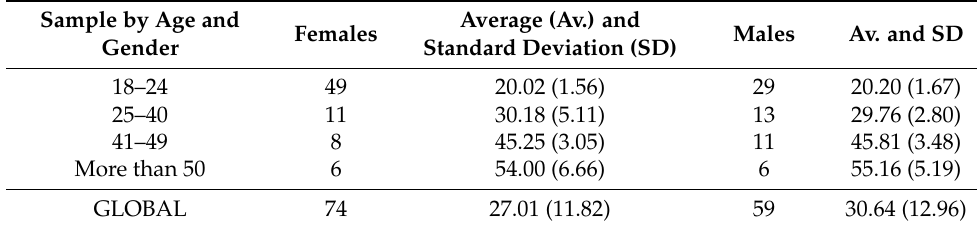
Table 1. Sample data by age and gender.